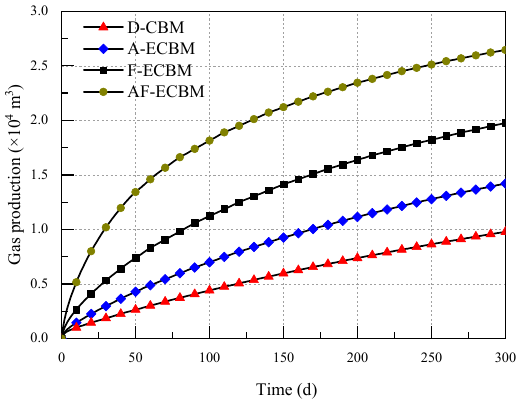
Figure 11. Gas production of different recovery schemes.